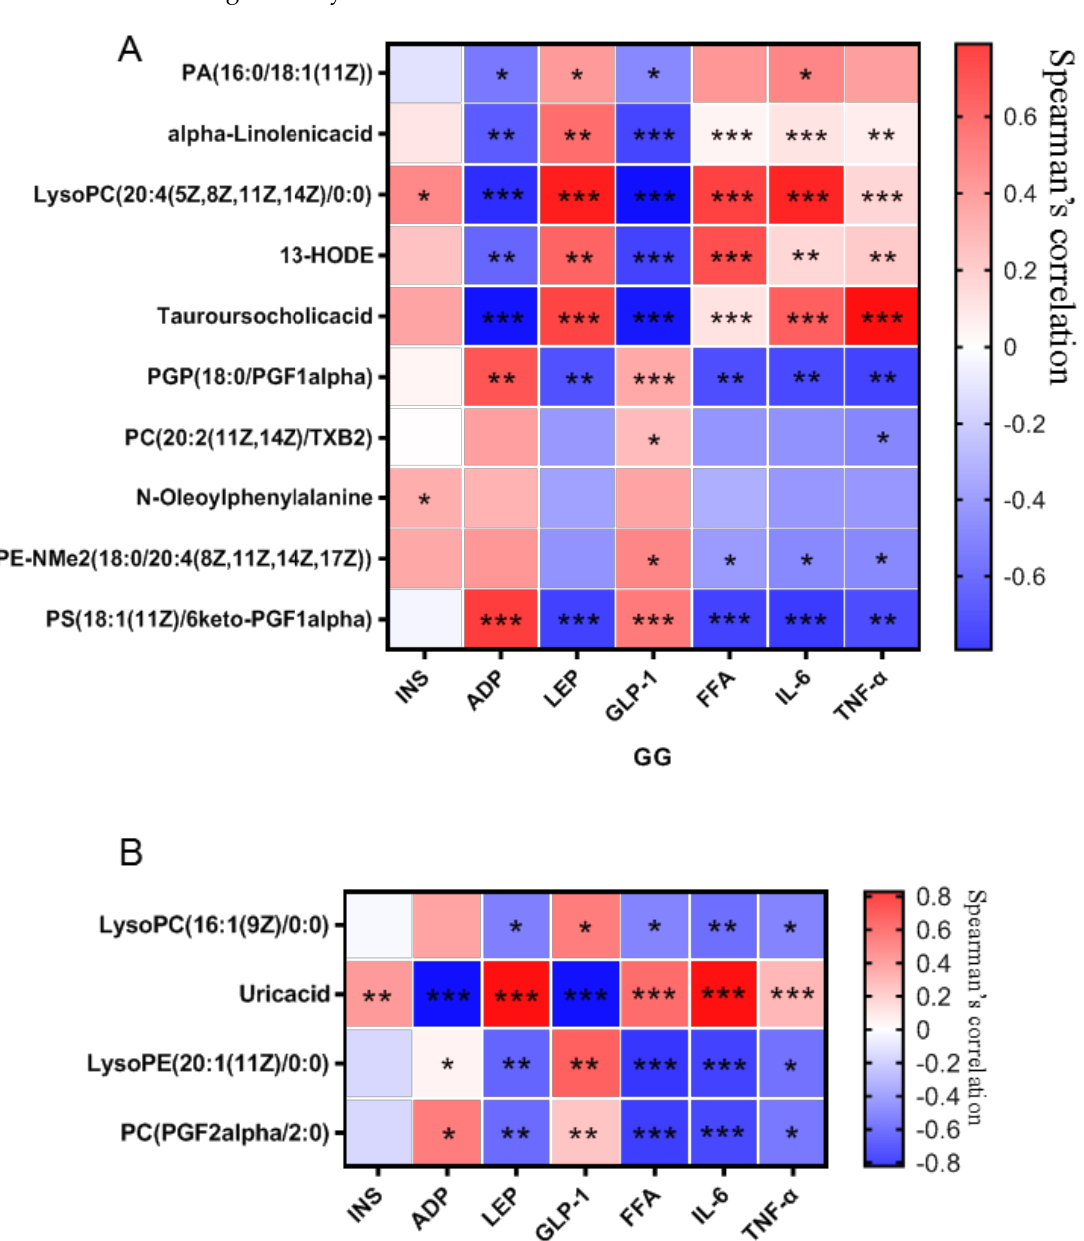
Figure 12. Correlation analysis of metabolites and biochemical indices affected by Pueraria polysaccharide intervention (( A ): GG; ( B ): FG; red represents a positive correlation, blue represents a negative correlation, * p < 0.05, ** p < 0.01, *** p < 0.001).